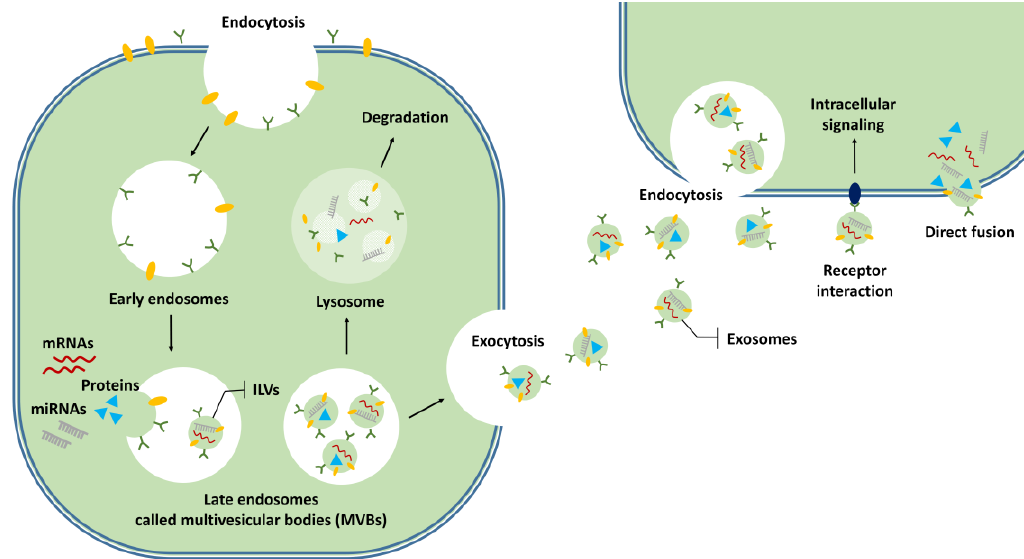
Figure 1. Formation of exosomes and uptake into target cells. Early endosomes are formed by endocytosis and they transition to late endosomes. These are called multivesicular bodies (MVBs), with intraluminal membrane vesicles (ILVs). ILVs that are released from MVBs into the extracellular space are called exosomes. Released exosomes are taken up by the target cells through endocytosis, interactions with receptors on the cell membrane, or direct fusion with the cell